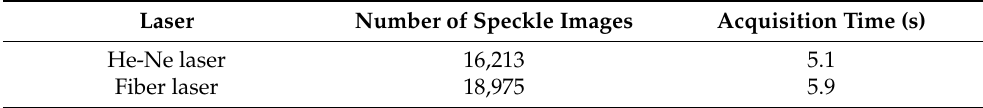
Table 5. The number of speckle images acquisitions for two laser datasets.